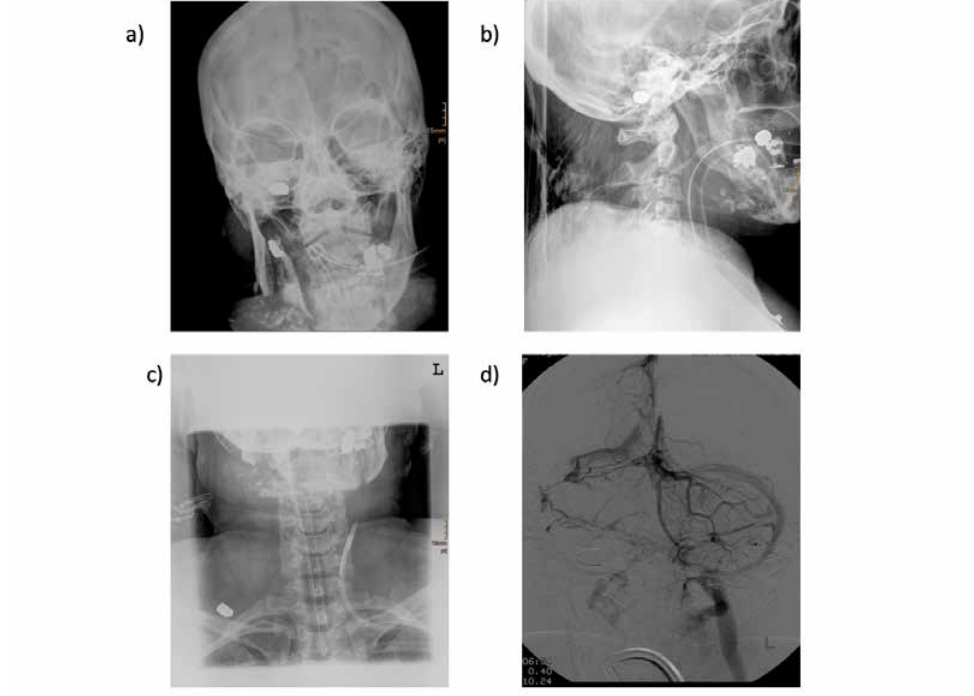
Figure 1 a-d: Smashed mandibular bone, with metal stemming from teeth restorations, and from the projectiles. Intact projectiles are seen in the sigmoid sinus (a and b), and the soft parts of the dorsum subcutaneously on the right side (c). The transverse and sigmoid sinus, and the jugular vein on the right side are blocked (d; venous phase after right vertebral artery injection).